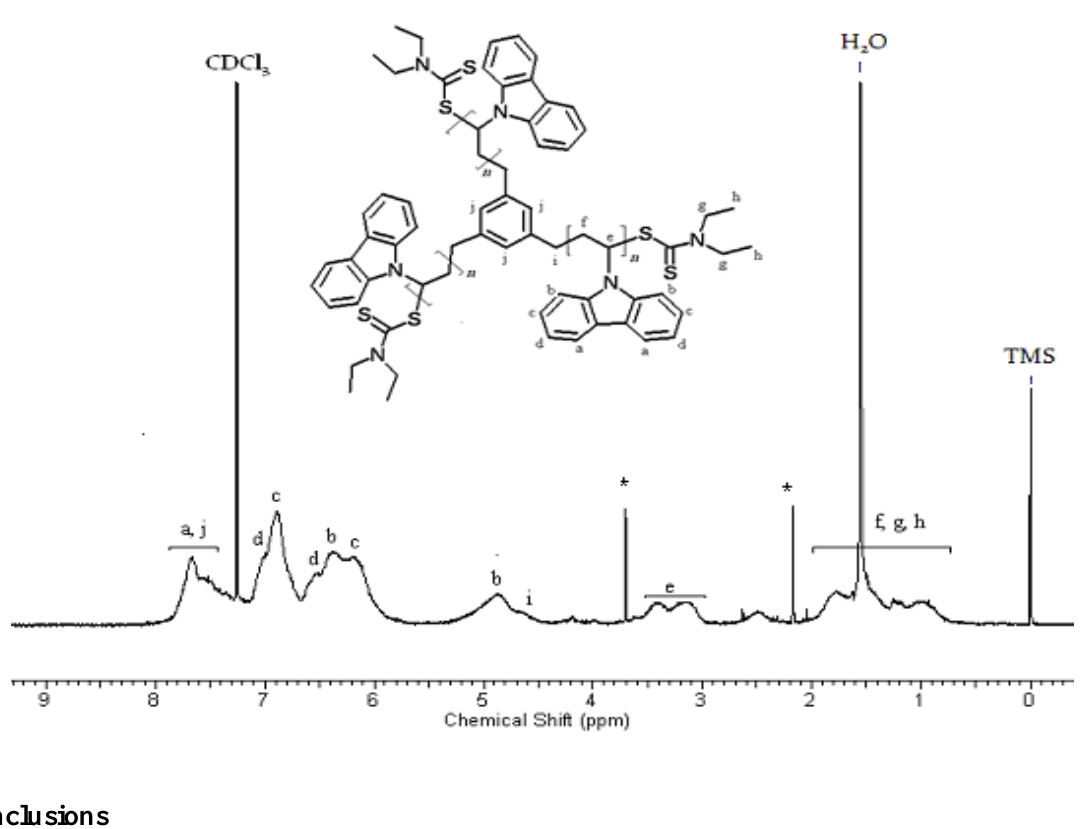
Figure 7. 1 H-NMR spectra (CDCl assigned to methanol